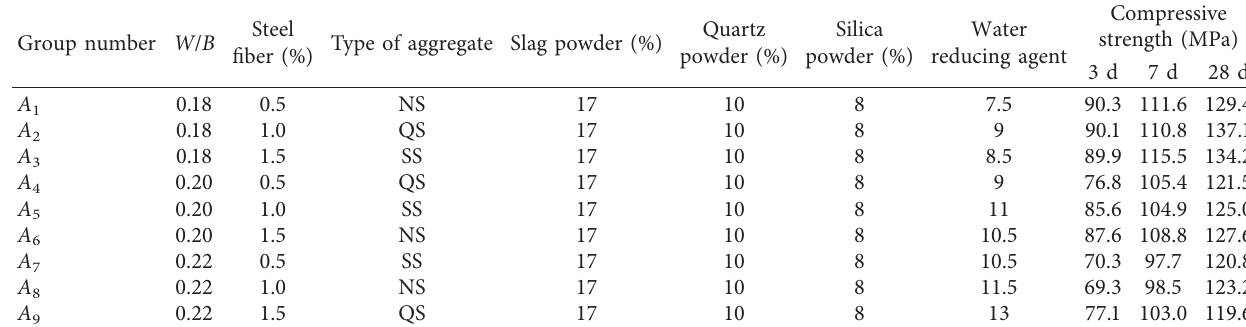
Table 6: Compressive strength test results of steel fiber UHPC orthogonal test (MPa). Group number W / B